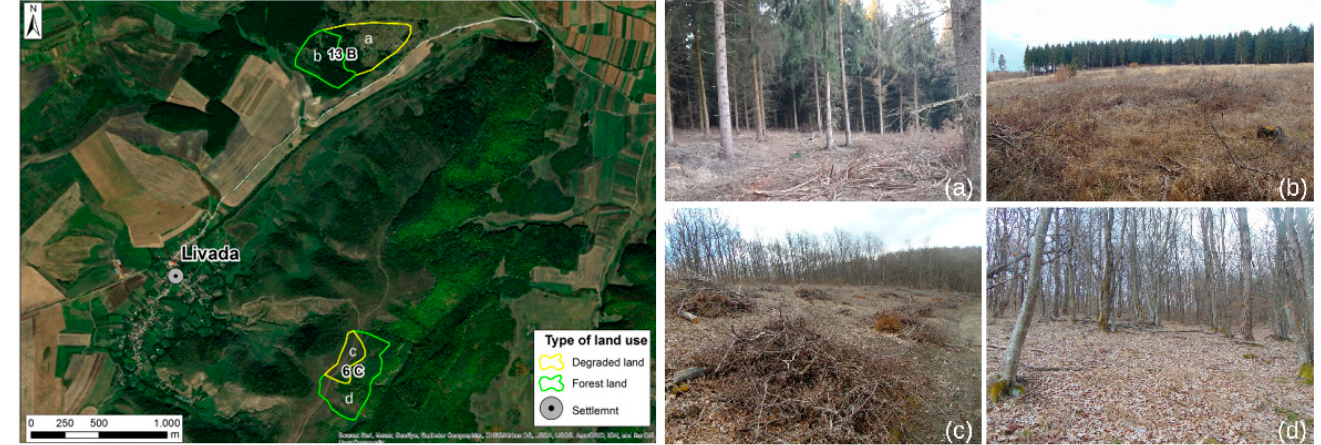
Figure 2. Sample plots and land type. Plots 13 B: ( a )—forest land; ( b )—degraded land; plots 6 C: ( c )—degraded land ( d )—forest land. ( c )—degraded land ( d )—forest